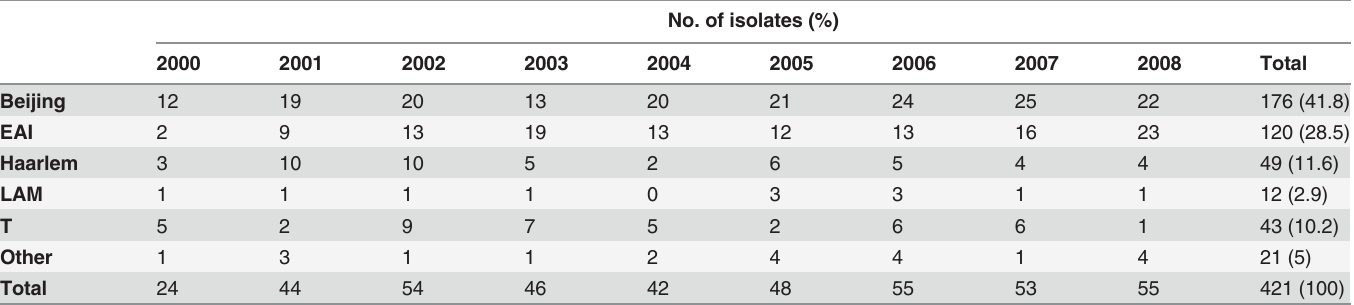
Table 1. Genotype distribution based on combined spoligotyping and MIRU-VNTR typing of MTB isolates from culture-positive TB patients in southern Taiwan, 2000 – 2008.